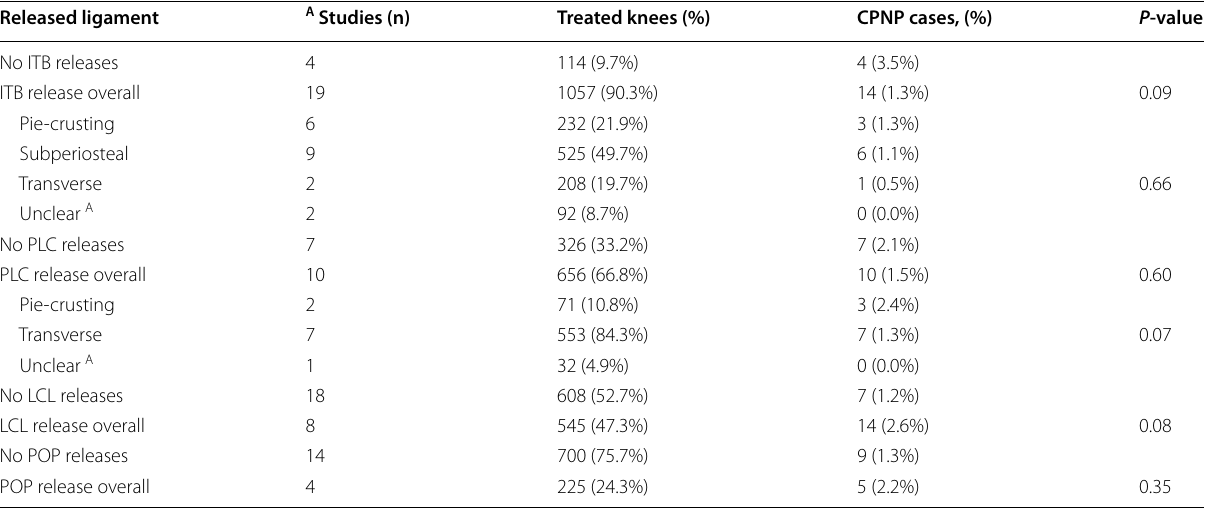
Table 5 Specific ligament release and CPNP ratio